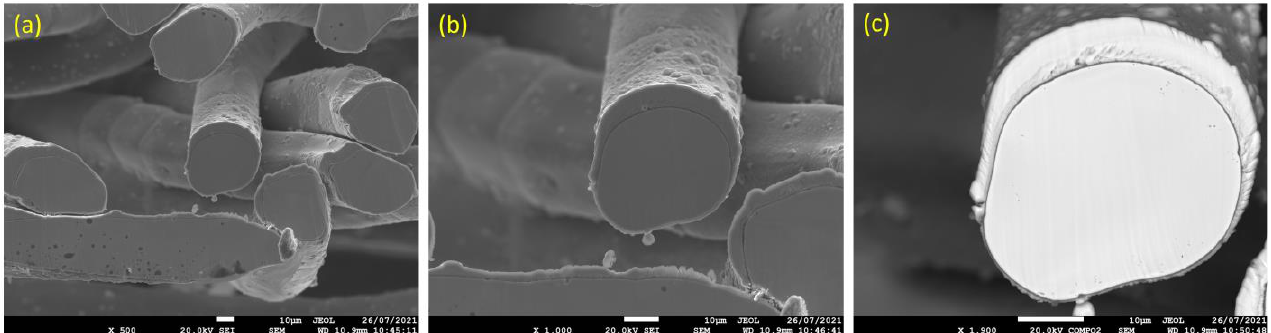
Figure 9. SEM micrographs of a cross section of 17 μm FeCrAl fibers, after one MSHT cycle, at different magnifications: ( a ) ×500, ( b ) ×1000, and ( c ) ×1900.